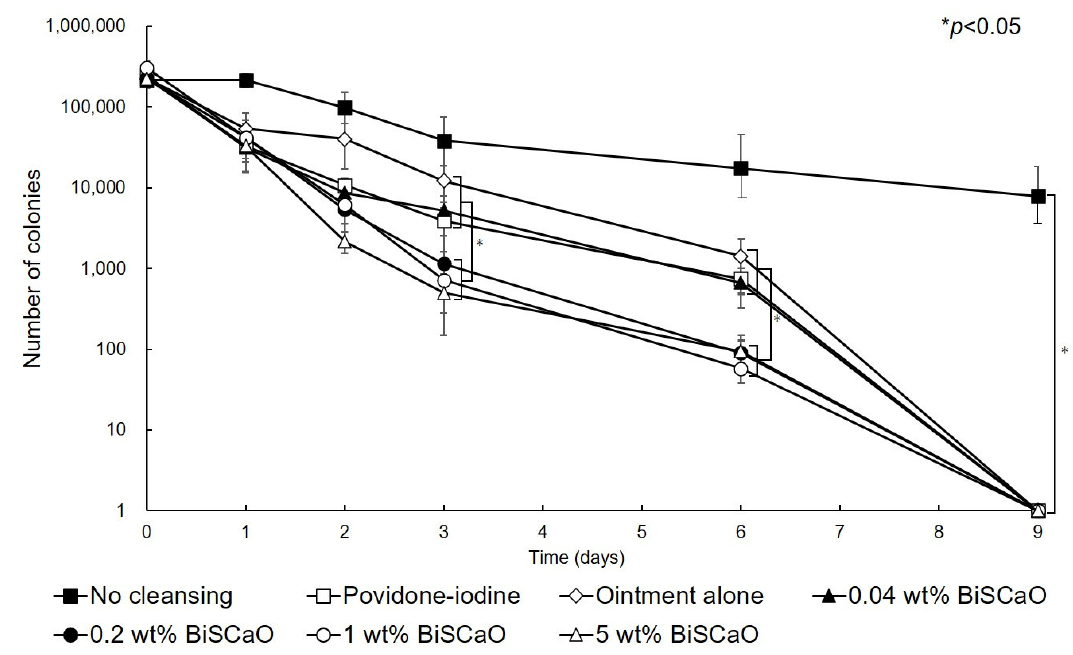
Figure 2. Eradication of P. aeruginosa colonies from wounds treated with disinfectant In Vivo. The P. aeruginosa –infected wounds on hairless rats were cleaned with saline, then each ointment was applied once daily on Days 1–3 and covered with chitin nanofiber sheets (CNFS). Wounds cleaned with saline once daily on Days 4–9 were covered with CNFS. After cleaning with saline, the contents of the wounds on the indicated day after wound creation were collected and the viable cell counts were measured. Data are presented as mean ± standard deviation (SD, n = 6).